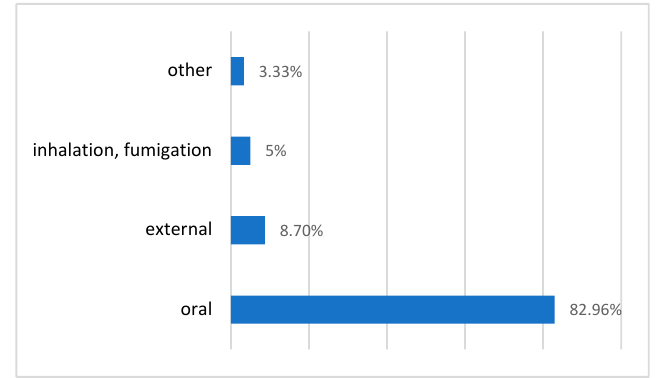
Figure 5. Routes for administering remedies.